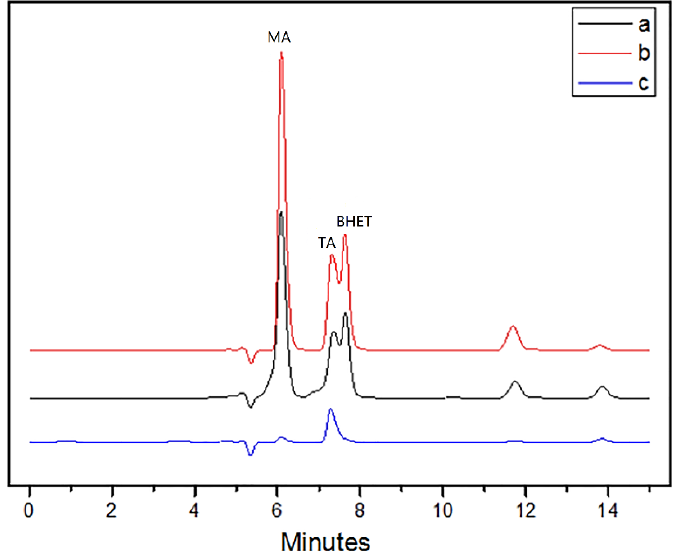
Figure 1. HPLC chromatogram of PET culture solution in whole cell catalysis. ( a ) whole-cell biocatalyzed